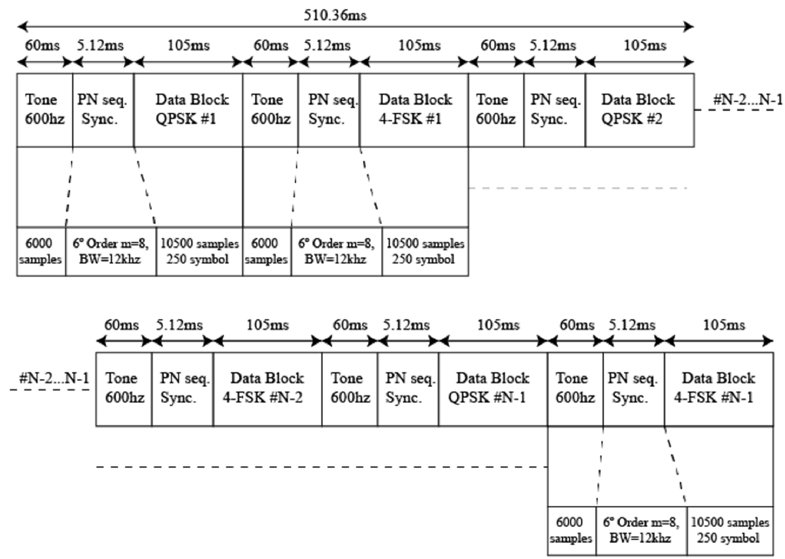
Figure 4. Frame Figure 4. Frame design.